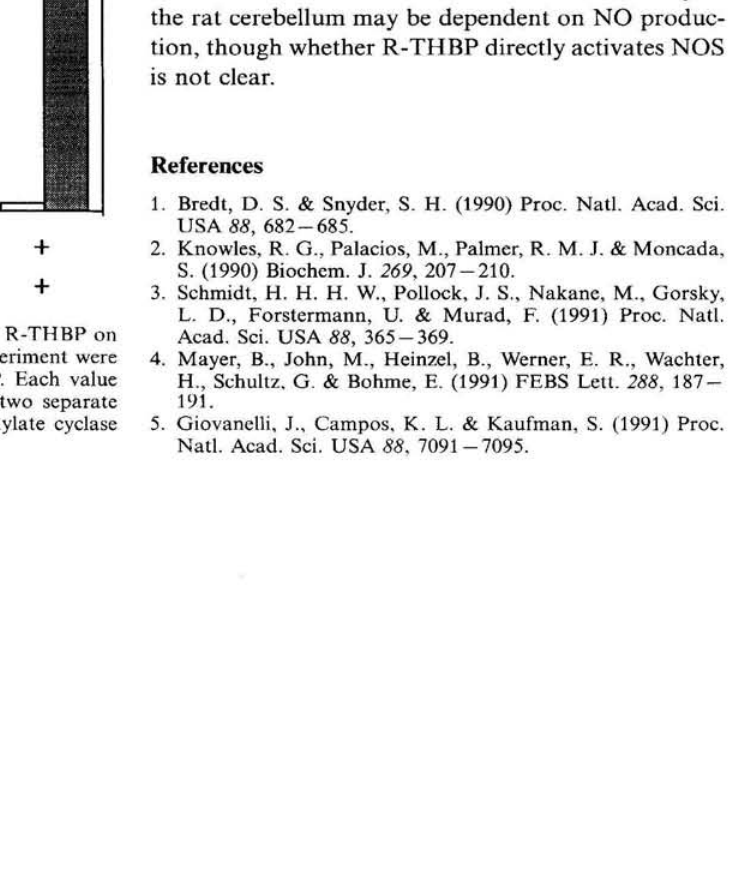
Figure 1. Effect of the co-existence of DTT with R-THBP on sGC activity. The concentrations used in this experiment were 10 μΜ for DTT and SNP and 1 μΜ for R-THBP. Each value was determined in duplicates and the results of two separate experiments, and shows as a ratio to basal guanylate cyclase